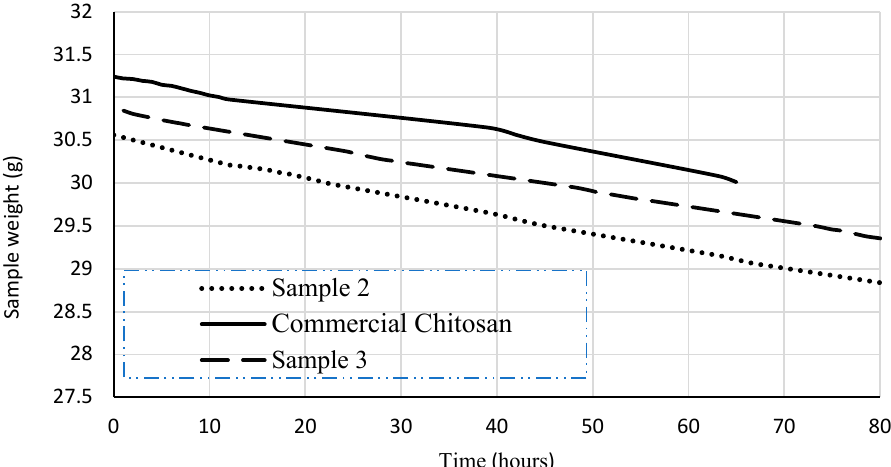
Figure 3. Weight loss for the assemblage using films made with commercial chitosan and extracted chitosan, in permeability experiments.